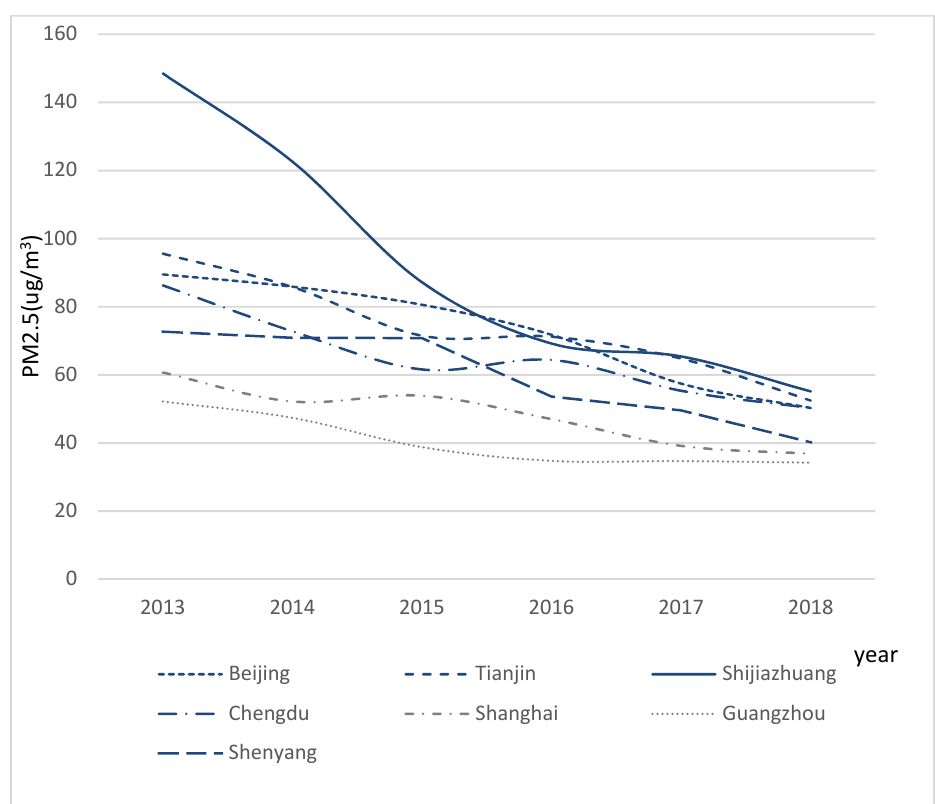
Figure 2. The average annual PM2.5 of 3 municipalities directly under the Central Government and four provincial capitals from 2013 to 2018. Five of these seven cities are the top 10 cities in China, and they are distributed in the major economic development areas, which are representative of the changes of urban air quality in China. This shows the change in the annual mean value of PM2.5 in seven cities during 2013–2018 after the “Ten Rules of Qi” was implemented. At the beginning of 2013, the annual average PM2.5 of all cities exceeded the national standard of 36 mg/m 3 , and the degree of pollution in each city varied substantially. For instance, in 2013, the average PM2.5 concentration in Shijiazhuang reached 148.5 mg/m 3 , nearly three times the level in Guangzhou, 52.2 mg/m 3 , which presented the best air quality in the same period. However, by 2018, the air quality of every city had improved significantly and showed obvious convergence